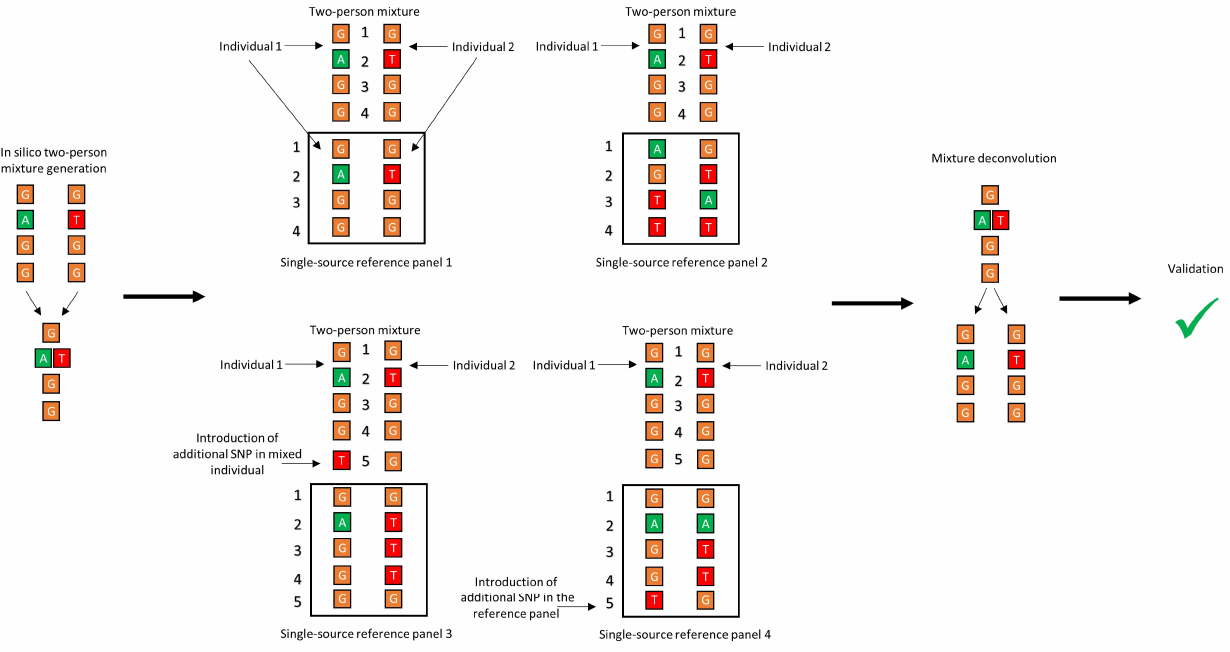
Figure 1. Graphical representation of the differences of the 4 reference panels used in the mixture deconvolution